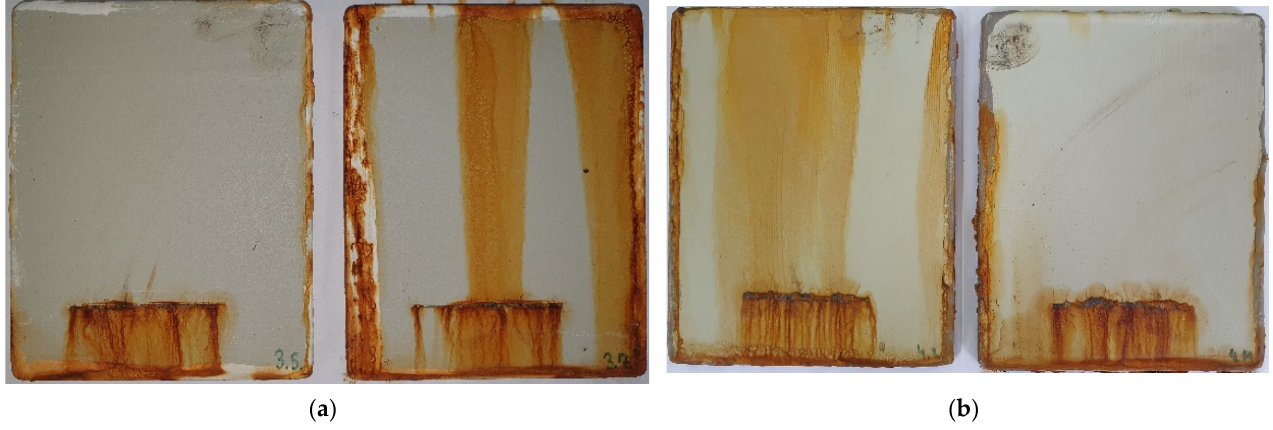
Figure 2. Coating systems with ( a ) and without ( b ) zinc in the primer after 720 h exposure in salt spray chamber according to ISO 9227.